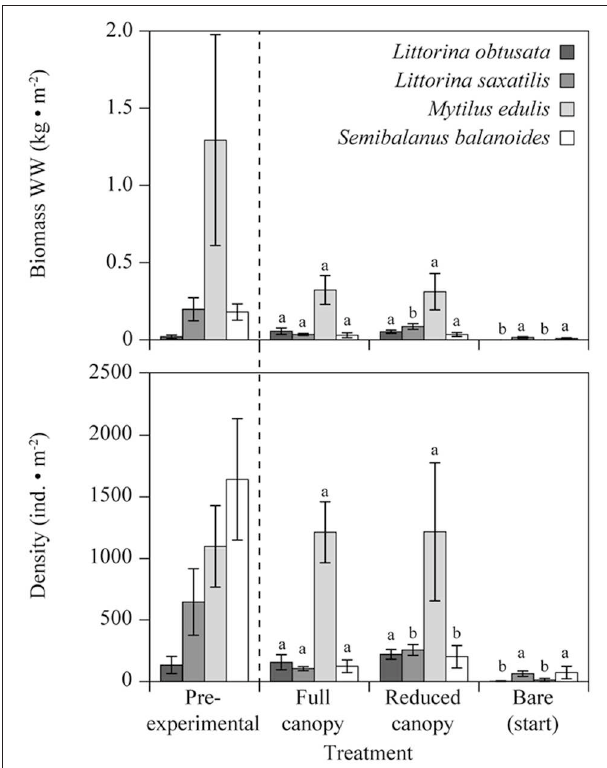
FIGURE 3 | (A) Biomass and (B) density of dominating intertidal faunal species in Kobbefjord across the treatments “Full canopy.” “Reduced canopy” and “Bare (start)” measured in August 2014 and the “Pre-experimental” community measured in August 2011. Letters annotate significant differences of p < 0.05 by a post-hoc test between main treatments for each species, i.e., excluding “Pre-experimental.” N = 5 for all mean values. Error bars are SE.